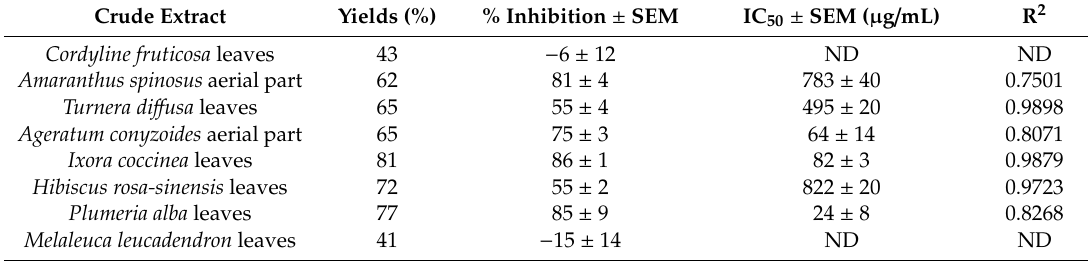
Table 2. The extract yields from eight selected plants and their % inhibition against MMP9 in vitro at 1 mg / mL alongside with their IC 50